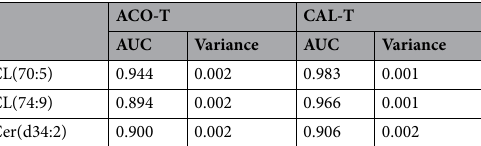
Table 3. 5-fold cross-validations of ROC analyses of three potential lipid biomarkers. Notes, AUC: area under curve, ACO-T, CAL-T, the AUC values to diagnose ACO-T and CAL rats from their respective